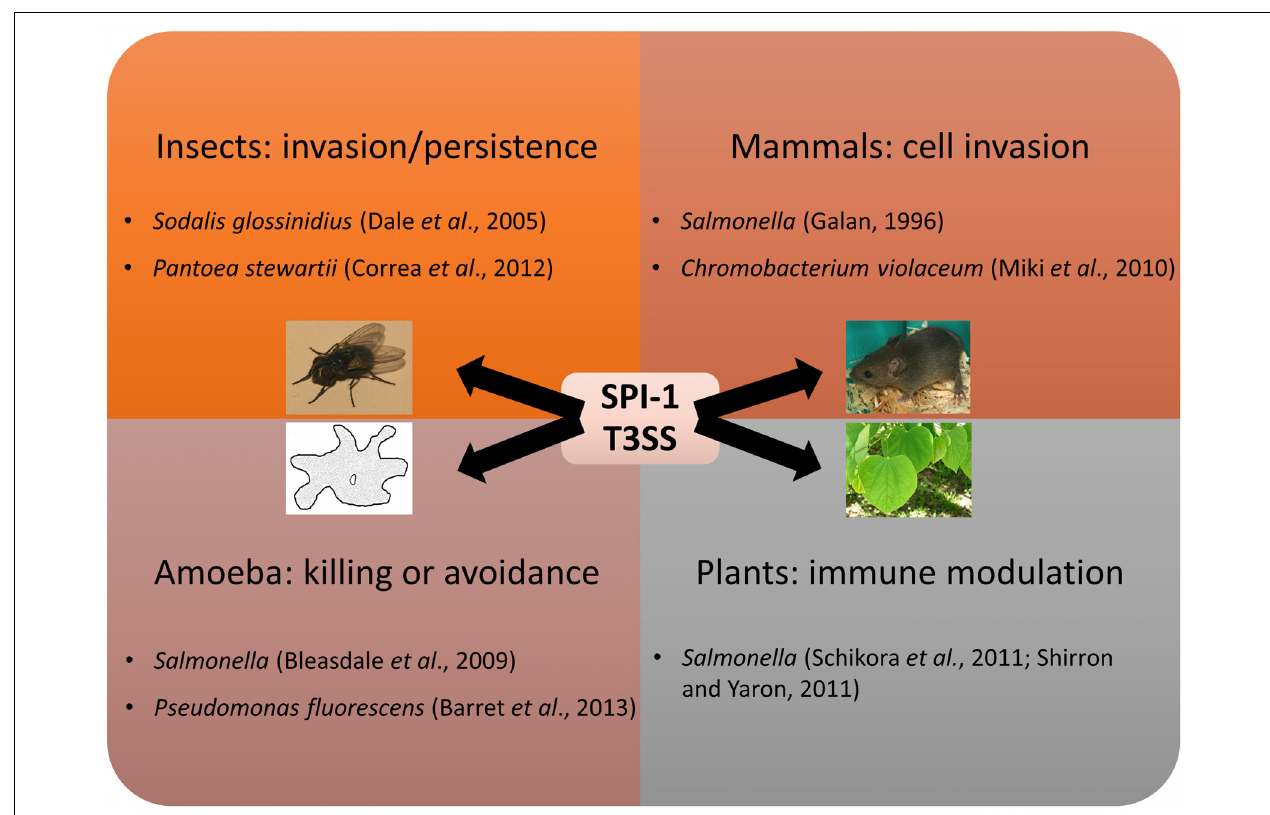
FIGURE 2 | Multiple roles of the SPI-1T3SS. The SPI-1T3SS was first implicated in virulence towards mammals, but has since been shown to mediate interactions with other animals, protozoa, and plants.